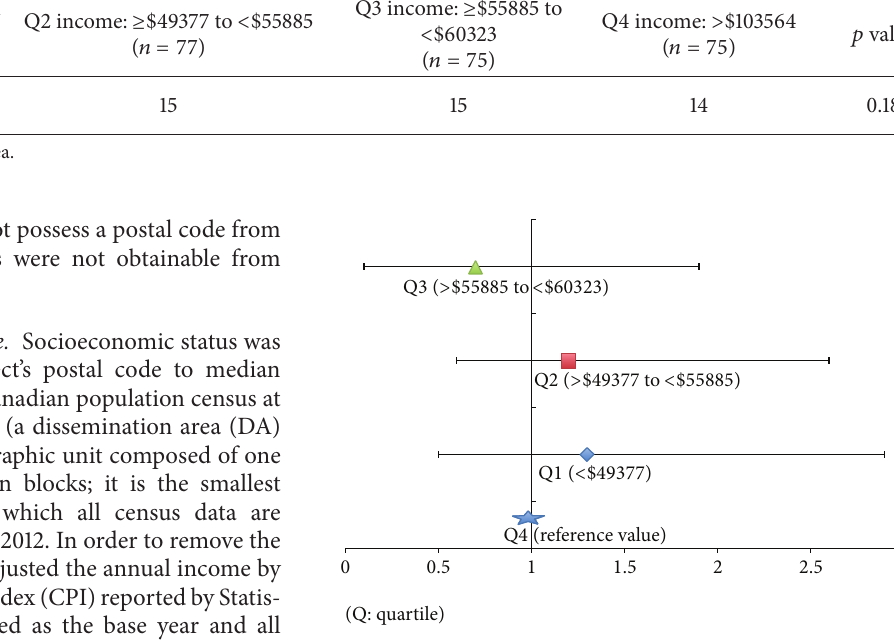
Figure 1: Adjusted odds ratio for prediction of burn injury based on median family income